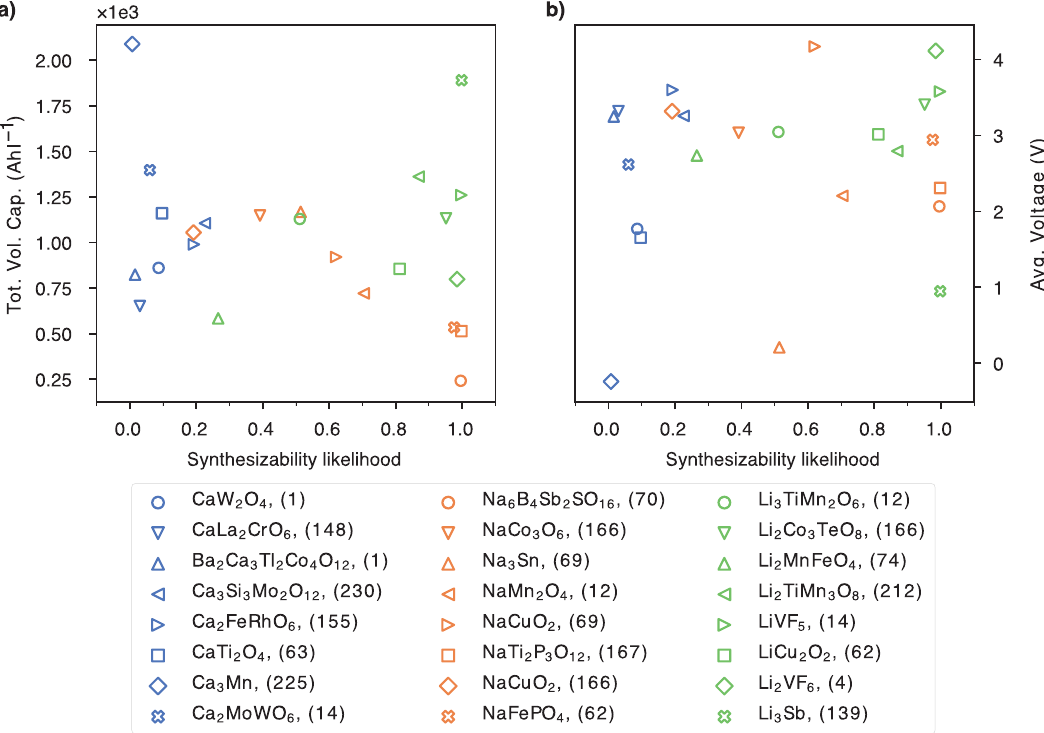
Fig. 5 Predicted synthesizability likelihood versus electrode materials properties. Synthesizability likelihood of selected electrode samples against their ( a ) volumetric capacity and ( b ) average voltage. Each crystal sample is identi fi ed by its chemical formula followed by the space group number in parenthesis. For the sake of visualization, each working-ion is color-coded differently: Li as green, Na as orange, and Ca as blue. These plots can be utilized similarly to Ashby charts for materials selection. In this case, the ideal candidates lie near the top right of each plot to increase the synthesizability and the desired electrode